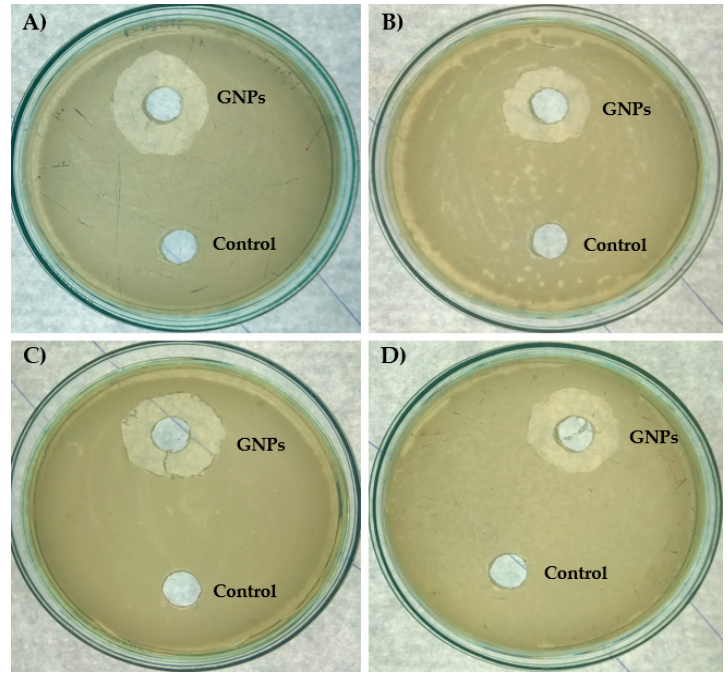
Figure 2. Qualitative assessment of antibacterial activity of GNPs. Müeller–Hinton (MH) agar plates were seeded with standardized suspensions (equivalent to the 0.5 McFarland) of ( A ) Escherichia coli , ( B ) Staphylococcus aureus , ( C ) Salmonella abony , and ( D ) Klebsiella pneumonia . Equal amounts of GNPs and PBS (negative control) were poured in the wells made in MH plates. After overnight incubation at 37 °C, inhibition zones around wells of GNPs (10 µg/mL) against all tested bacterial species, in comparison to control, were observed.